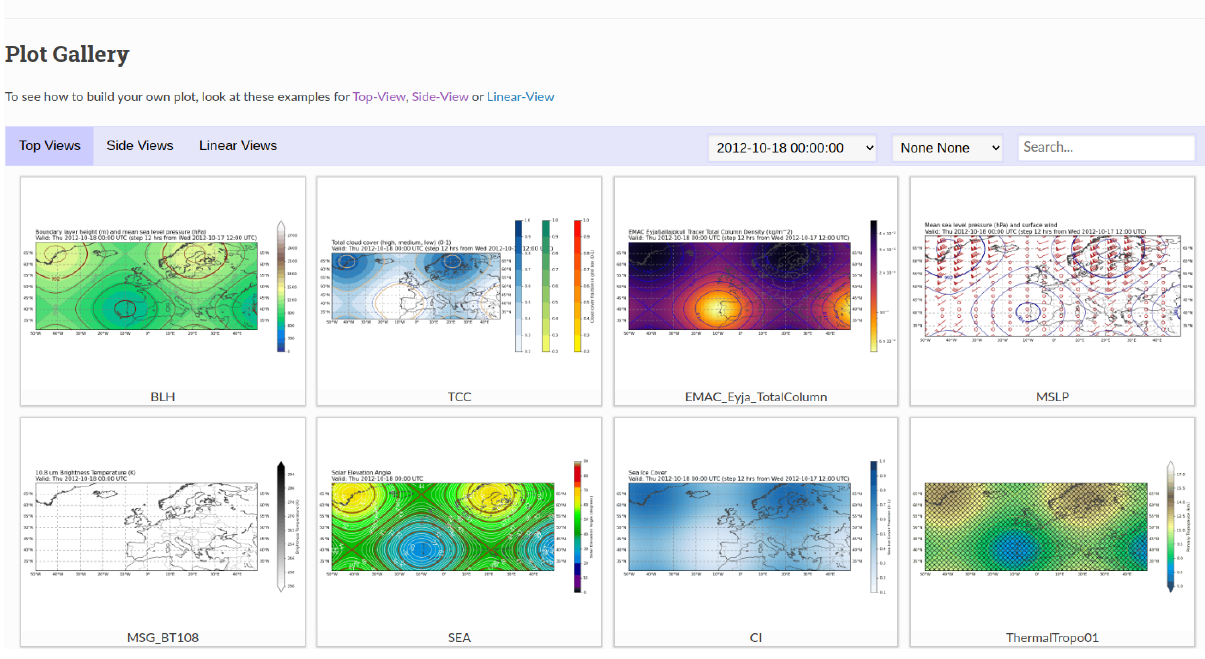
Figure A1. Example of plot gallery from the MSS